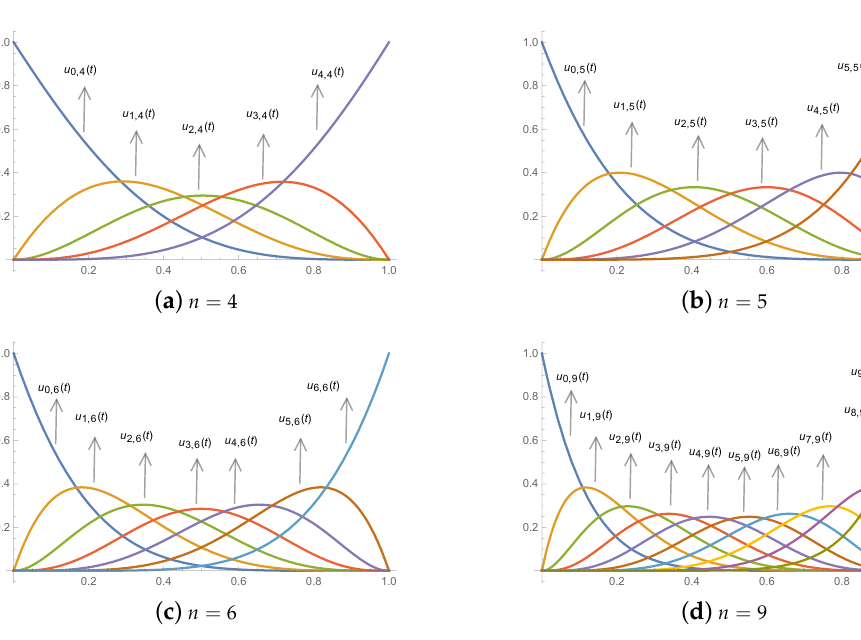
Figure 1. gB-like